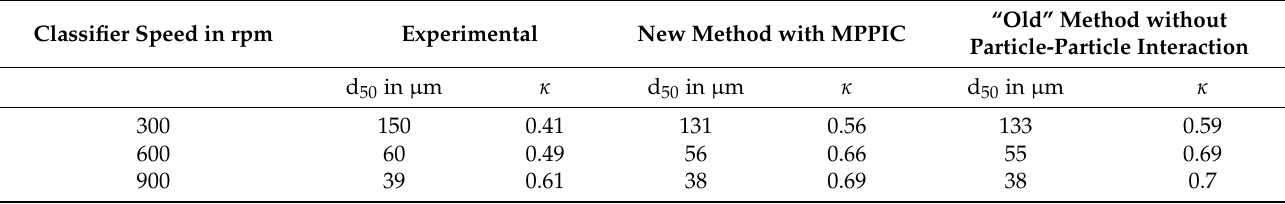
Table 4. Comparison classification efficiency d 50 and classification selectivity κ in experiment, new method with MPPIC and solver without particle-particle interaction. Classifier Speed in rpm Experimental New Method with